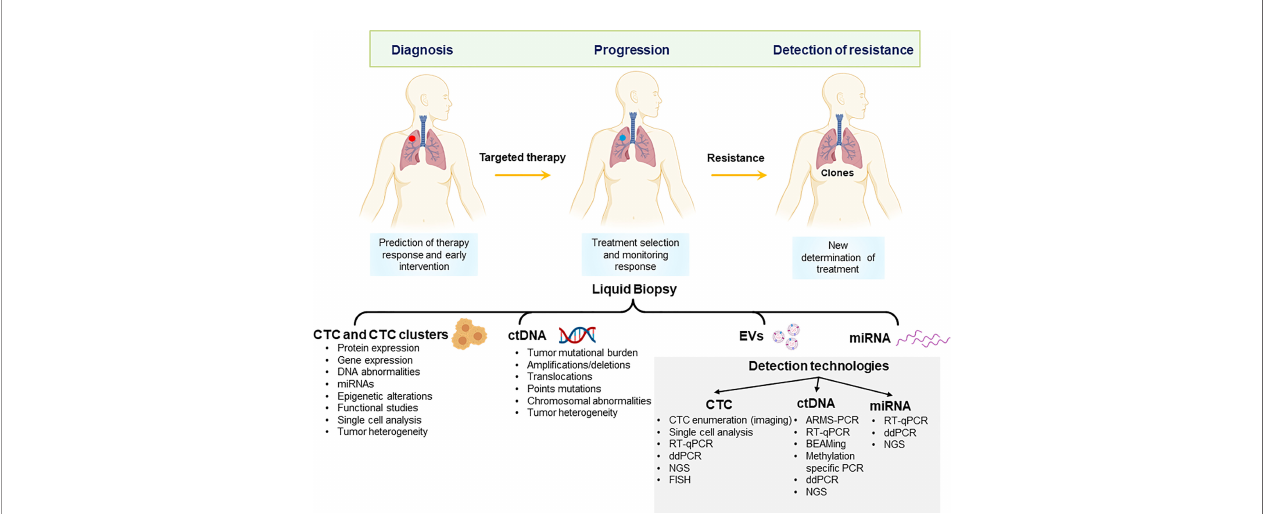
FIGURE 1 | Potential applications of liquid biopsy in the management of non-small cell lung cancer. Liquid biopsy derivatives can be applied to early diagnosis, monitor of response to treatment and detection of resistance to treatment. CTCs, Circulating tumour cells and clusters; ctDNA, circulating tumour DNA; EV, extracellular vesicles; miRNA, microRNA; NGS, next-generation sequencing; ddPCR, digital droplet PCR; FISH, fl uorescent in situ